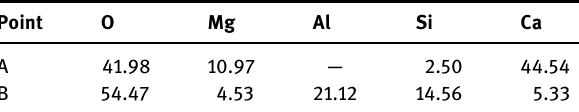
Table 9: Composition of crucible ( wt% ) at selected points